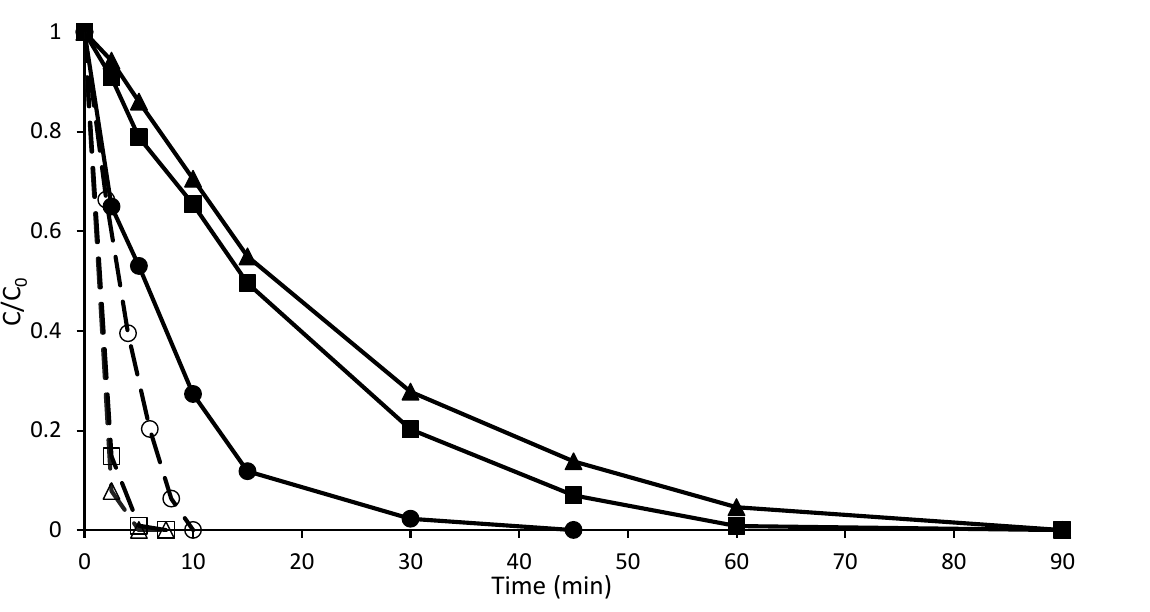
6 of 14 Figure 2. Plot of the relative concentration of acetaminophen (C/C 0 , where C 0 = 1 mg L − 1 ) when irra- diated in the presence of a different concentration of H2O2: 0 mM ( X ), 11 mM ( ), 21 mM ( ● ), 43 mM ( ■ ) and 107 mM ( ▲ ). Experiments were carried out by bubbling oxygen (O 2 ), nitrogen (N 2 ) and air, when irradiating with and without H 2 O 2 (Figure 3). In the absence of hydrogen peroxide, the direct photolysis of acetaminophen was faster in the absence of oxygen (bubbling N 2 ex- periment) than when this gas was present. This might be due to the quenching of the ex- cited states of acetaminophen by the oxygen, which decreases the photolysis rate of this pollutant [29,30]. However, the primary removal of acetaminophen does not guarantee decontamination, and under an N 2 atmosphere, the absence of a final electron acceptor